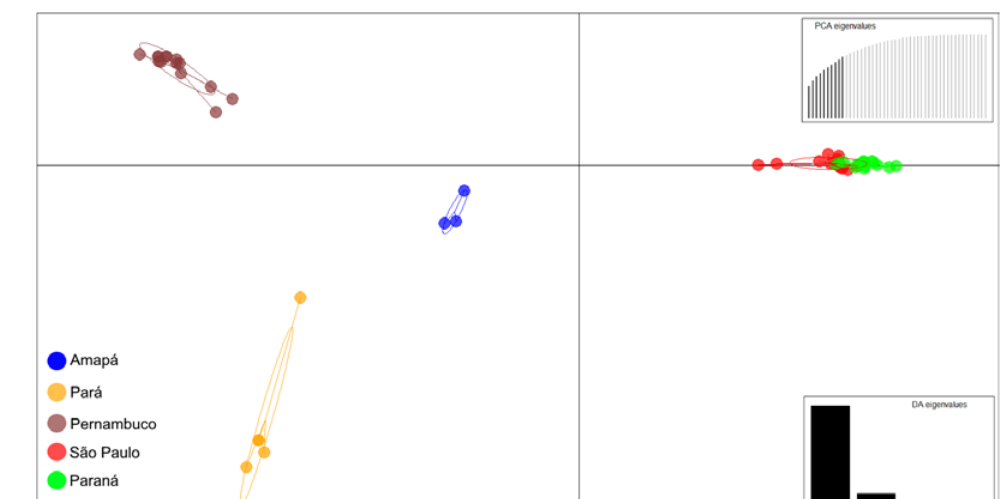
Figure 1. Bayesian Analysis of Genetic Similarity among geographical Pseudobatos percellens popula- tions performed on STRUCTURE results (k = 2) for 52 individuals from 3329 SNPs.